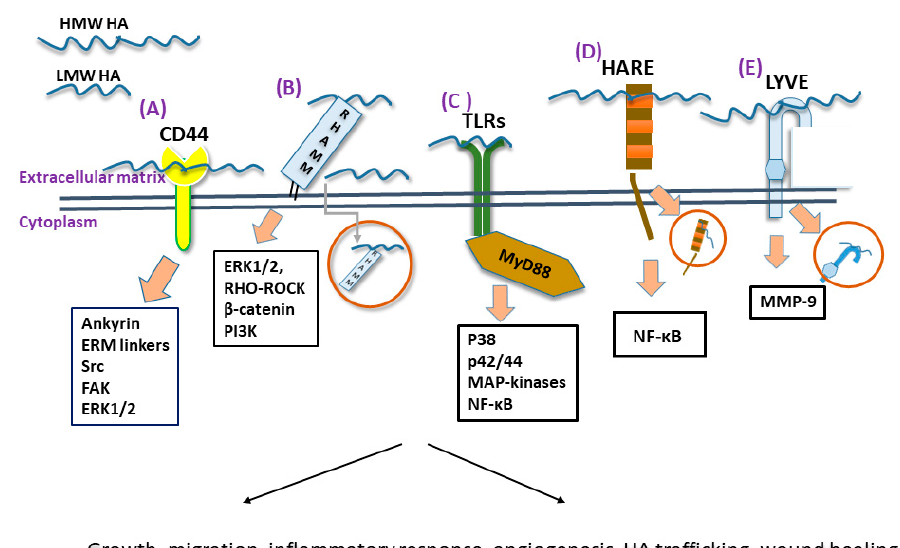
Figure 3. Mechanisms of HA action. ( A ) Upon activation, the intracellular CD44 domain binds with the cytoskeletal linker protein ankyrin and the ERM linkers, denominated as ezrin, radixin, and moesin (ERM), to regulate cell functions. Upon binding of LMW HA to CD44 Src Kinase, FAK and ERK1/2 are phosphorylated to stimulate cell growth, motility, and angiogenesis. ( B ) The binding of HMW HA to RHAMM regulates Ras/ERK/12 activities and initiates PI3K-dependent Rac activation and increased migration of arterial smooth muscle cells. ( C ) The binding of LMW HA to TLRs induces MyD88, downstream MAP-kinase activation and Nf- κβ nuclear translocation to enhance the inflammatory response. ( D ) HARE executes the systemic clearance of HA. In contrast, LMW HA binding initiates NF- κ B-dependent gene expression. ( E ) LYVE-1 is involved in HA clearance and endothelial transmigration of lymphocytes. An LYVE-1-dependent interaction of macrophages with the pericellular HA matrix of smooth muscle cells enhances MMP-9-dependent inhibition of arterial stiffness.